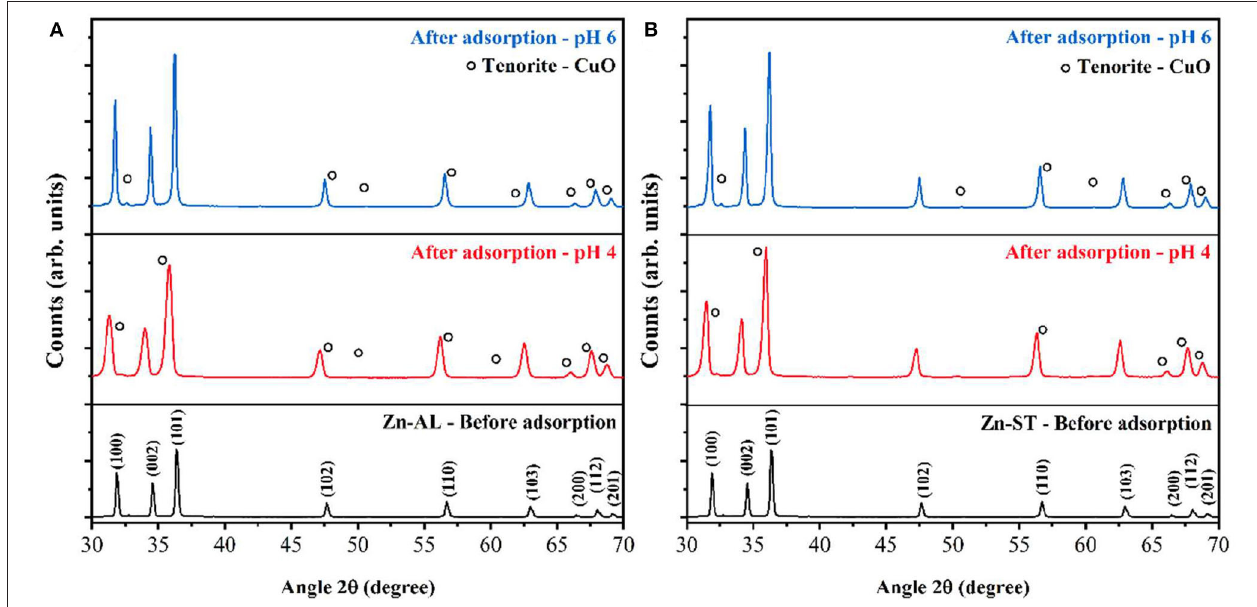
FIGURE 12 | XRD pattern before adsorption of copper solution 50mg L − 1 , pH 4, and 6: (A) Zn-AL and (B) Zn-ST.